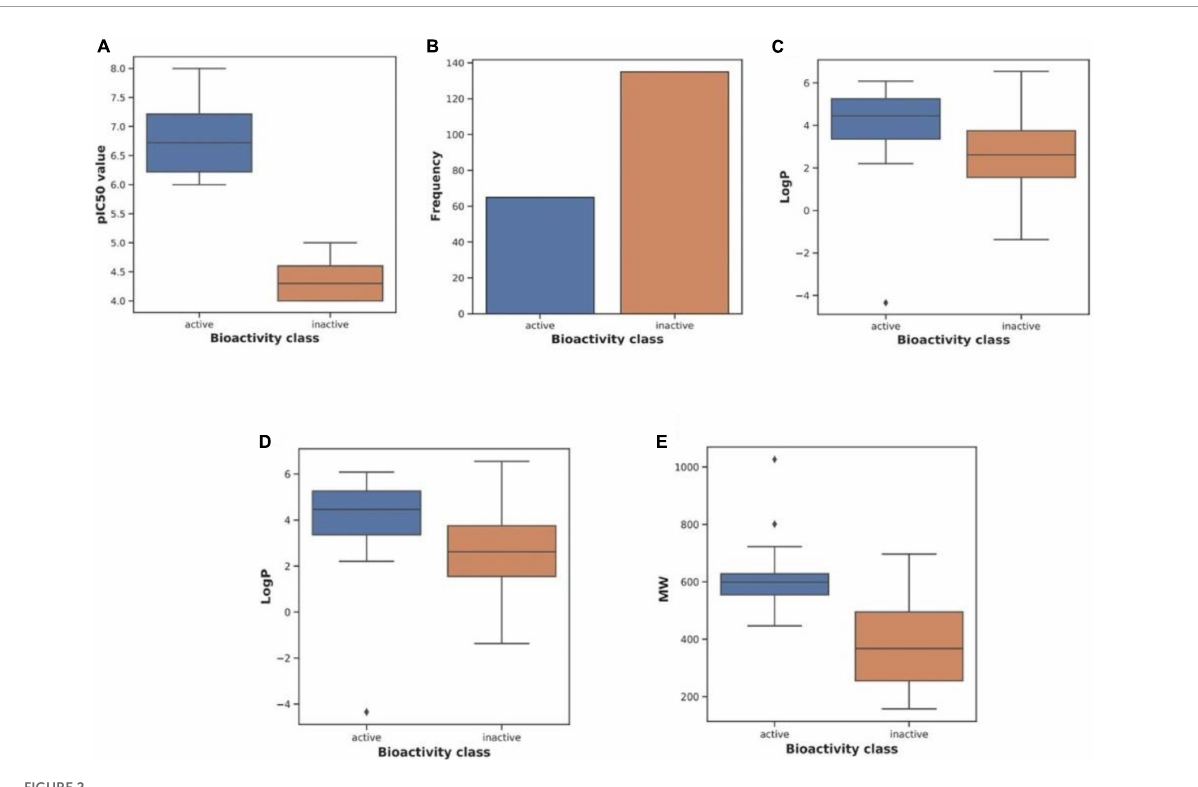
FIGURE2 Characteristics of the curated dataset. Adopted from